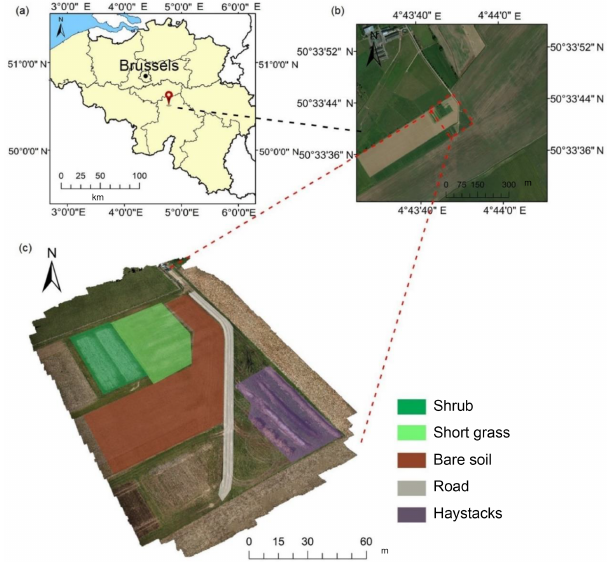
Figure 1. Description of the study sites. (a) Location of the study site, (b) satellite image of the study site and (c) classification of the surface used in the analysis. Note: (a) and (b) are taken from © Google Maps, and (c) is produced by UAV